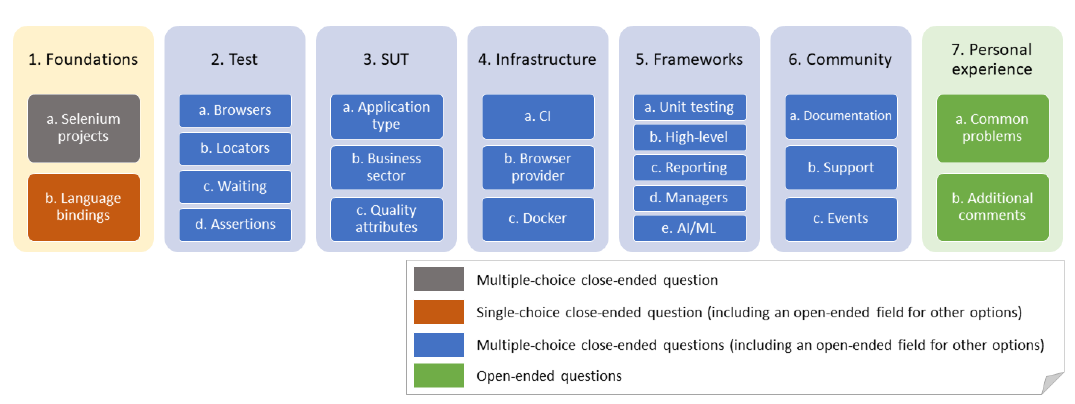
Figure 4. Survey